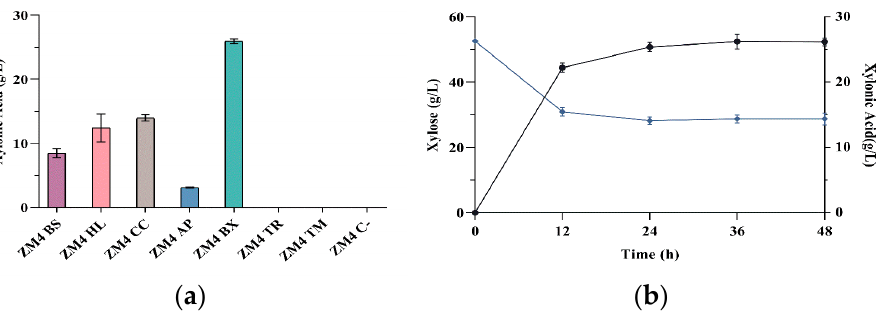
Figure 1. ( a ) Production of xylonic acid by Z. mobilis strains expressing different XDH genes from the following microorganisms: Brevundimonas subvibrioides (BS); Halomonas lutea (HL); Caulobacter crescentus (CC); SAR116 cluster alpha proteobacterium HIMB100 (AP); Paraburkholderia xenovorans (BX); Trichoderma reesei (TR) and Phaeoacremonium minimum (TM). Fermentation was performed in shake flasks for 48 h at 30 ◦ C in modified RM 1 medium containing 50 g L − 1 xylose. ( b ) Time course production of xylonic acid (dark blue circles) and xylose consumption (light blue diamonds) of ZM4 BX. The strain was grown in shake flasks with 50 g L − 1 xylose at 30 ◦